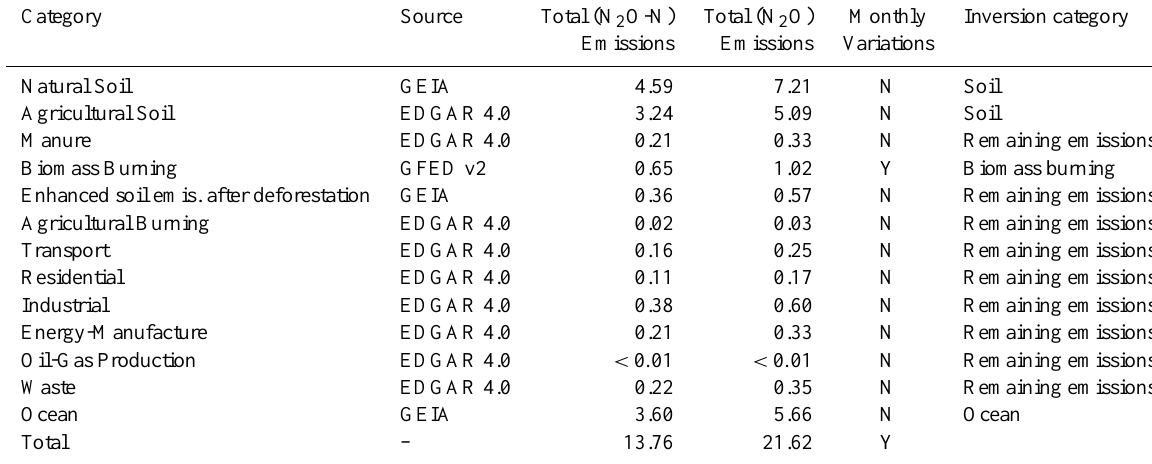
Table 3. Emission inventories used as a priori estimate in the inversion. Units for total emissions are TgN/yr for column 3 and TgN 2 O/yr for column 4. Emission categories are assigned to 4 source groups compiled in the last column, which are optimized independently in the inversions. The Monthly Variations column indicates if the inventories are constant over the year (N) or if monthly varying values are available